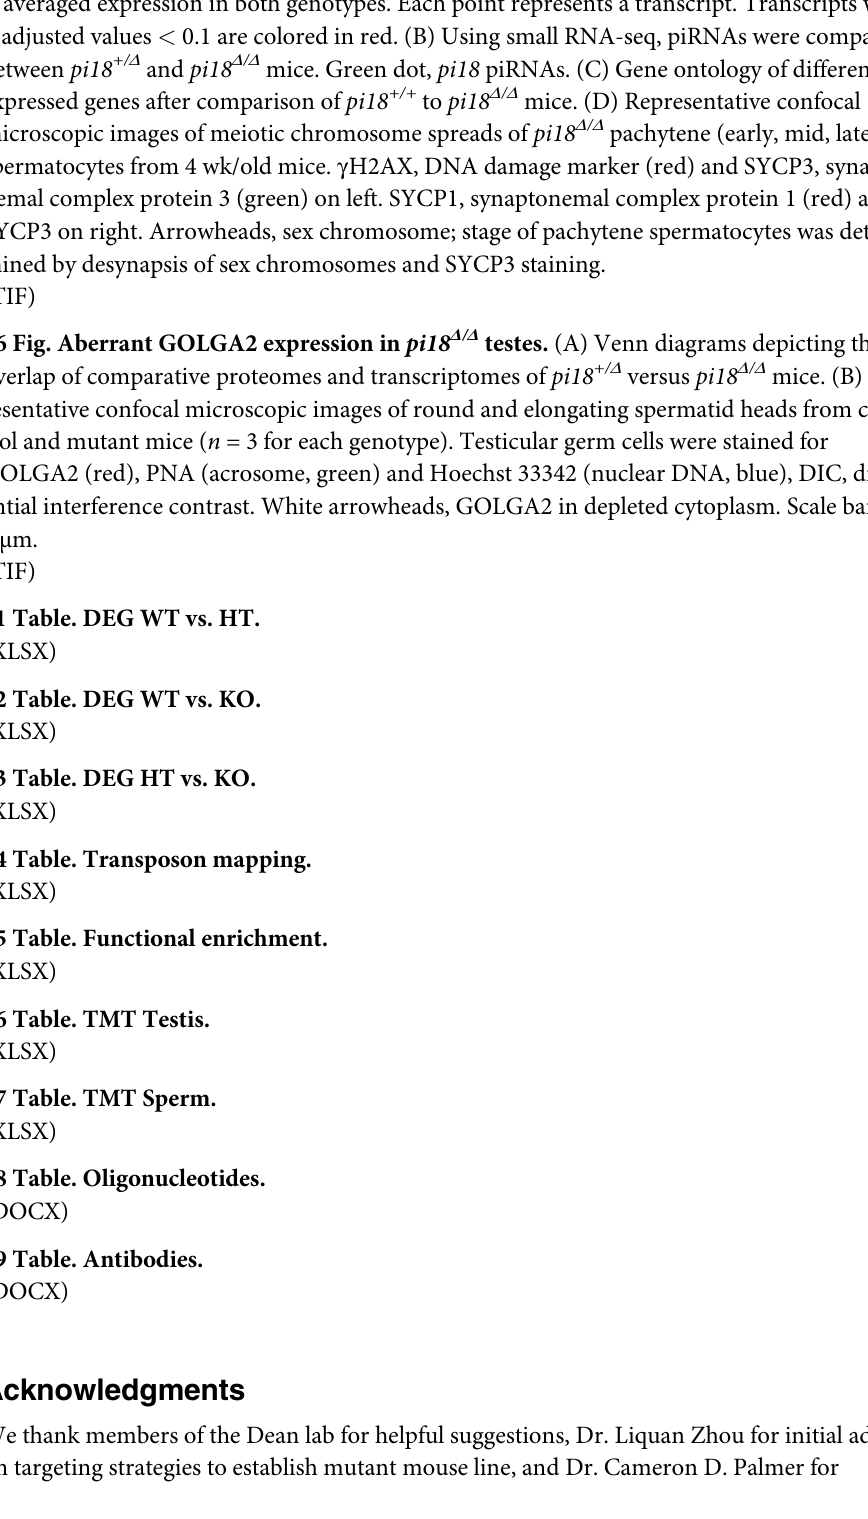
S5 Fig. Altered abundance of transcripts in pi18 Δ / Δ mice. (A) MA-plots of transcripts in pi18 +/+ compared to pi18 Δ / Δ (left), pi18 +/ Δ mice (middle), and pi18 +/ Δ compared to pi18 Δ / Δ (right) determined by RNA-seq. The y-axis is the log fold change in expression and the x-axis 2 is averaged expression in both genotypes. Each point represents a transcript. Transcripts with P adjusted values < 0.1 are colored in red. (B) Using small RNA-seq, piRNAs were compared between pi18 +/ Δ and pi18 Δ / Δ mice. Green dot, pi18 piRNAs. (C) Gene ontology of differentially expressed genes after comparison of pi18 +/+ to pi18 Δ / Δ mice. (D) Representative confocal microscopic images of meiotic chromosome spreads of pi18 Δ / Δ pachytene (early, mid, late) spermatocytes from 4 wk/old mice. γ H2AX, DNA damage marker (red) and SYCP3, synapto- nemal complex protein 3 (green) on left. SYCP1, synaptonemal complex protein 1 (red) and SYCP3 on right. Arrowheads, sex chromosome; stage of pachytene spermatocytes was deter- mined by desynapsis of sex chromosomes and SYCP3 staining. S6 Fig. Aberrant GOLGA2 expression in pi18 Δ / Δ testes. (A) Venn diagrams depicting the overlap of comparative proteomes and transcriptomes of pi18 +/ Δ versus pi18 Δ / Δ mice. (B) Rep- resentative confocal microscopic images of round and elongating spermatid heads from con- trol and mutant mice ( n = 3 for each genotype). Testicular germ cells were stained for GOLGA2 (red), PNA (acrosome, green) and Hoechst 33342 (nuclear DNA, blue), DIC, differ- ential interference contrast. White arrowheads, GOLGA2 in depleted cytoplasm. Scale bar, 5 μ m. S1 Table. DEG WT vs. HT. S2 Table. DEG WT vs. KO. S3 Table. DEG HT vs. KO. S4 Table. Transposon mapping. S5 Table. Functional enrichment. S6 Table. TMT Testis. S7 Table. TMT Sperm. (XLSX) S8 Table. Oligonucleotides. S9 Table.